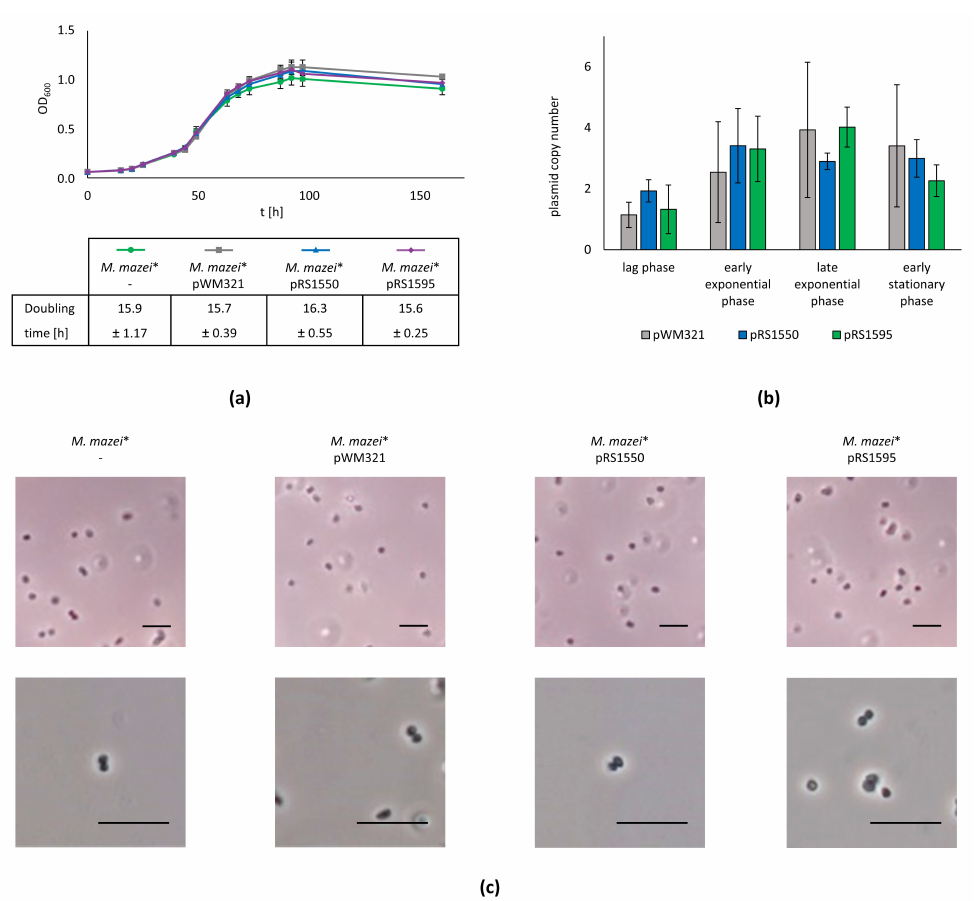
Figure 3. Analysing the effects of various plasmids and their copy number. ( a ) The growth behaviours of a wild type strain and strains carrying pWM321, pRS1550 or pRS1595 were monitored for 160 h. The experiment was carried out three times. Data represent mean values from one representative run containing three biological replicates each, with standard deviations shown as error bars. ( b ) The plasmid copy number was determined via qPCR during lag, early-exponential, late-exponential and stationary phase (24, 48, 72 and 96 h after inoculation, respectively). The experiment was carried out three times. Data represent mean values from one representative run containing three biological replicates, each measured in duplicate, with standard deviations shown as error bars. ( c ) The overall cell morphology was monitored using light microscopy. The scale bar represents 10 µ